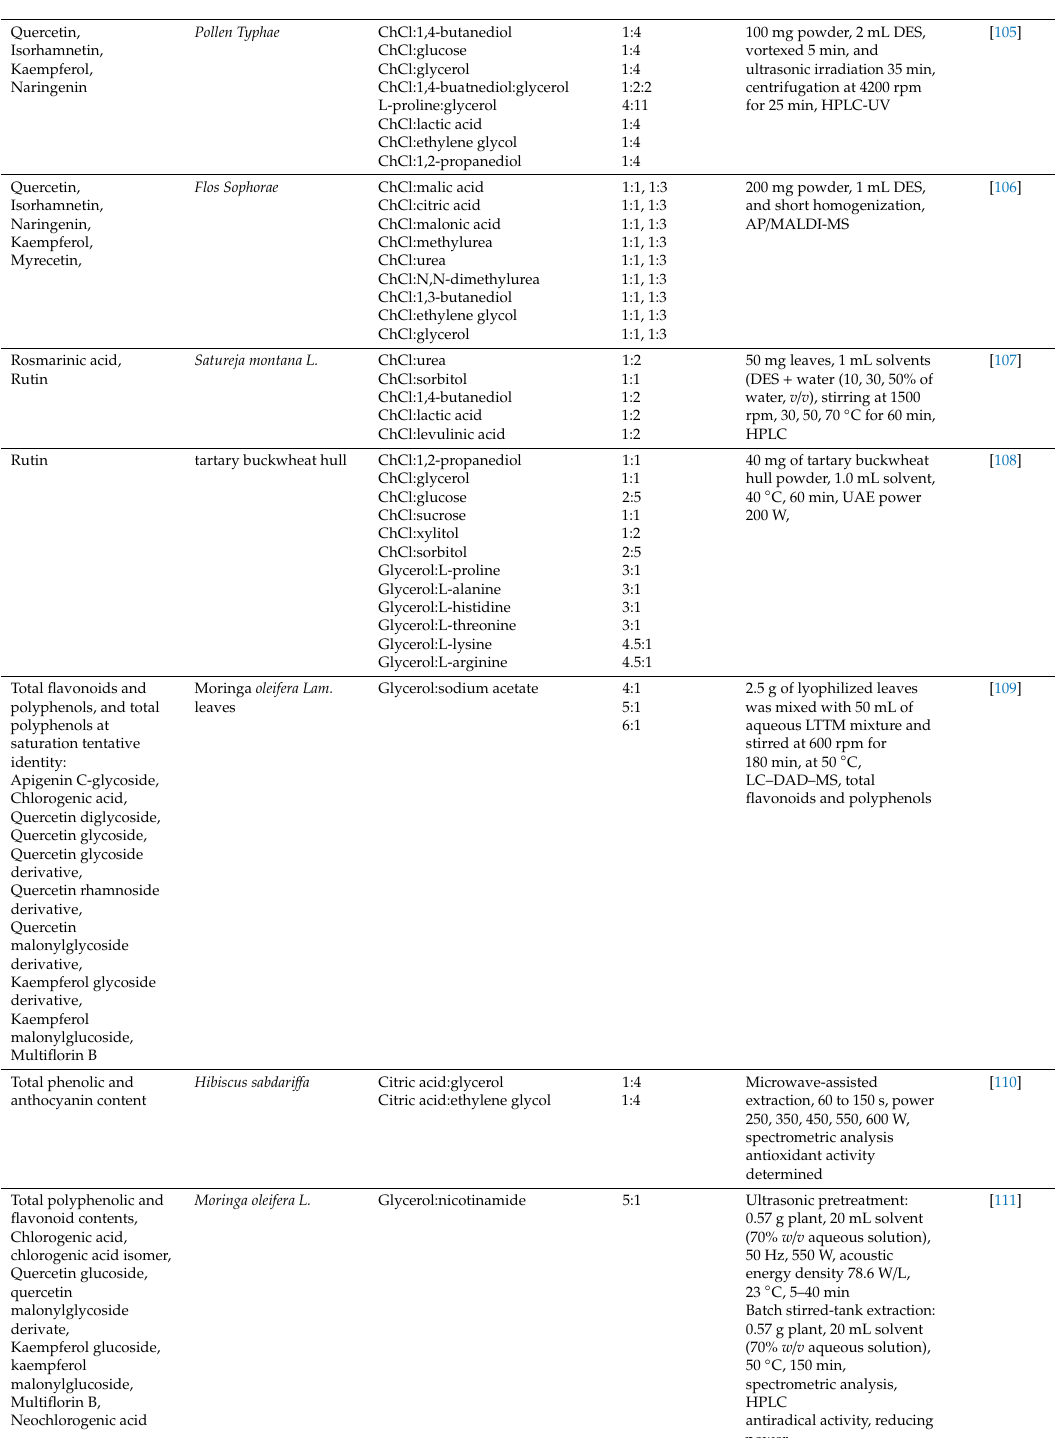
Total polyphenolic and flavonoid